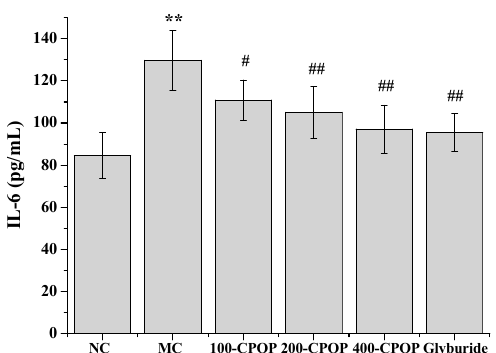
Figure 7. Effect of CPOP on interleukin-6 (IL-6) levels in STZ-induced diabetic rats. ** p < 0.01 vs. NC group ( N = 8); # p < 0.05, ## p < 0.01 vs. MC group ( N = 8). NC is the normal control group; MC is the model control group; 100-CPOP is the 100 mg/kg per body weight CPOP group; 200-CPOP is the 200 mg/kg per body weight CPOP group; 400-CPOP is the 400 mg/kg per body weight CPOP group.